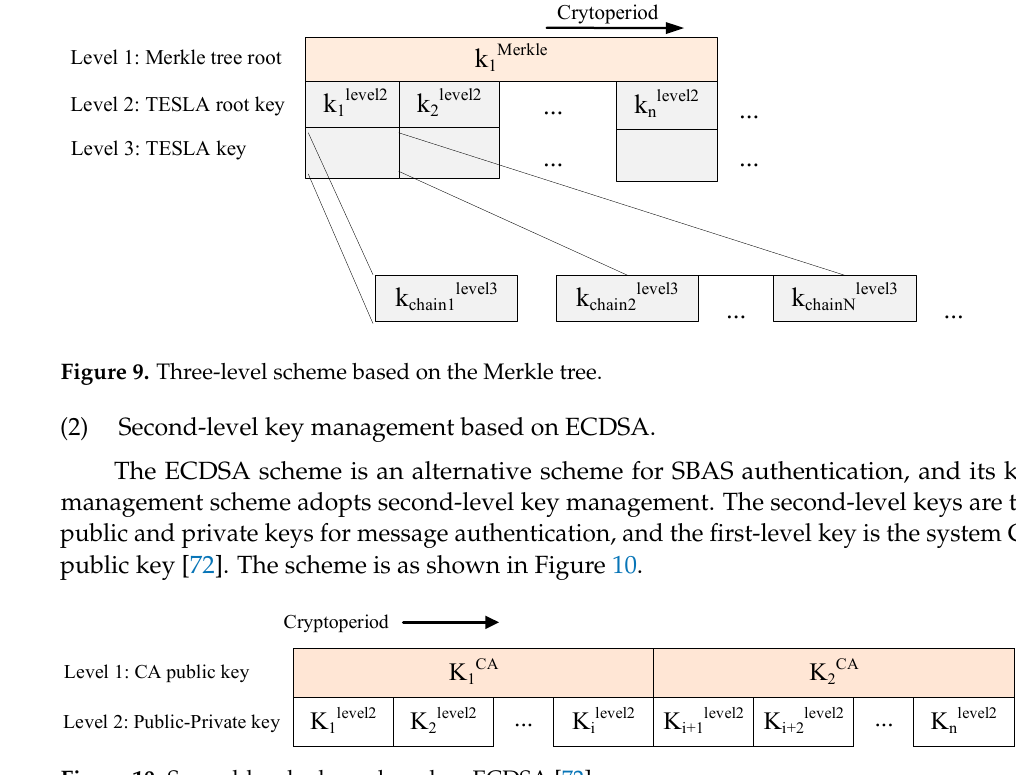
Figure 10. Second-level scheme based on ECDSA [72].